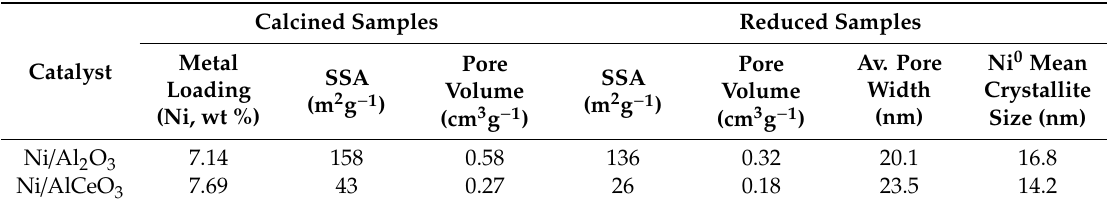
Table 1. Physicochemical, structural and textural properties of calcined and reduced catalysts. Catalyst